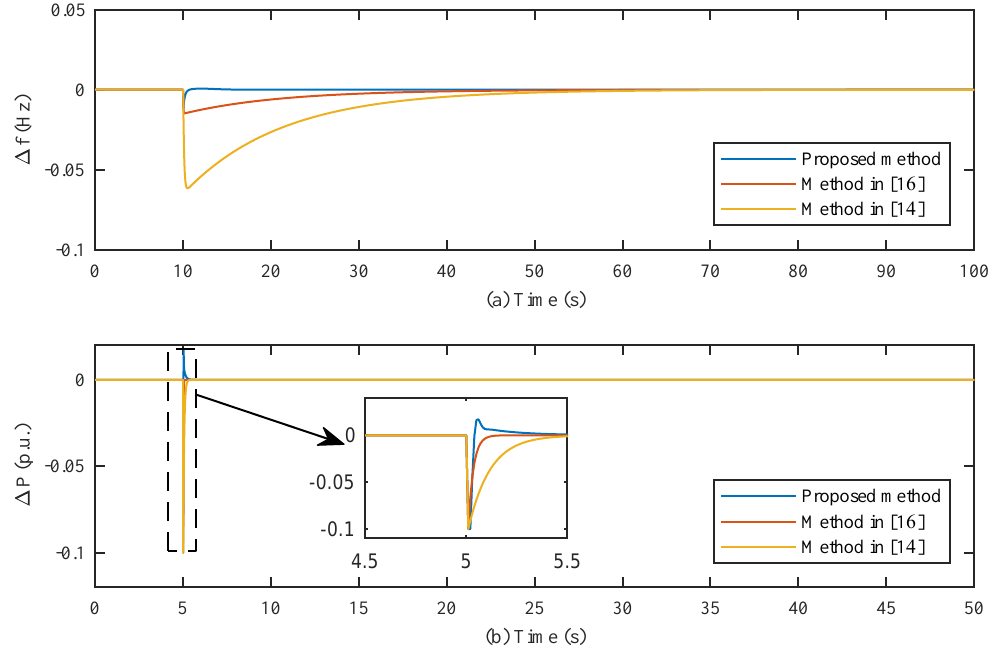
Figure 14. System transient response. ( a ) Microgrid frequency deviation. ( b ) Total power